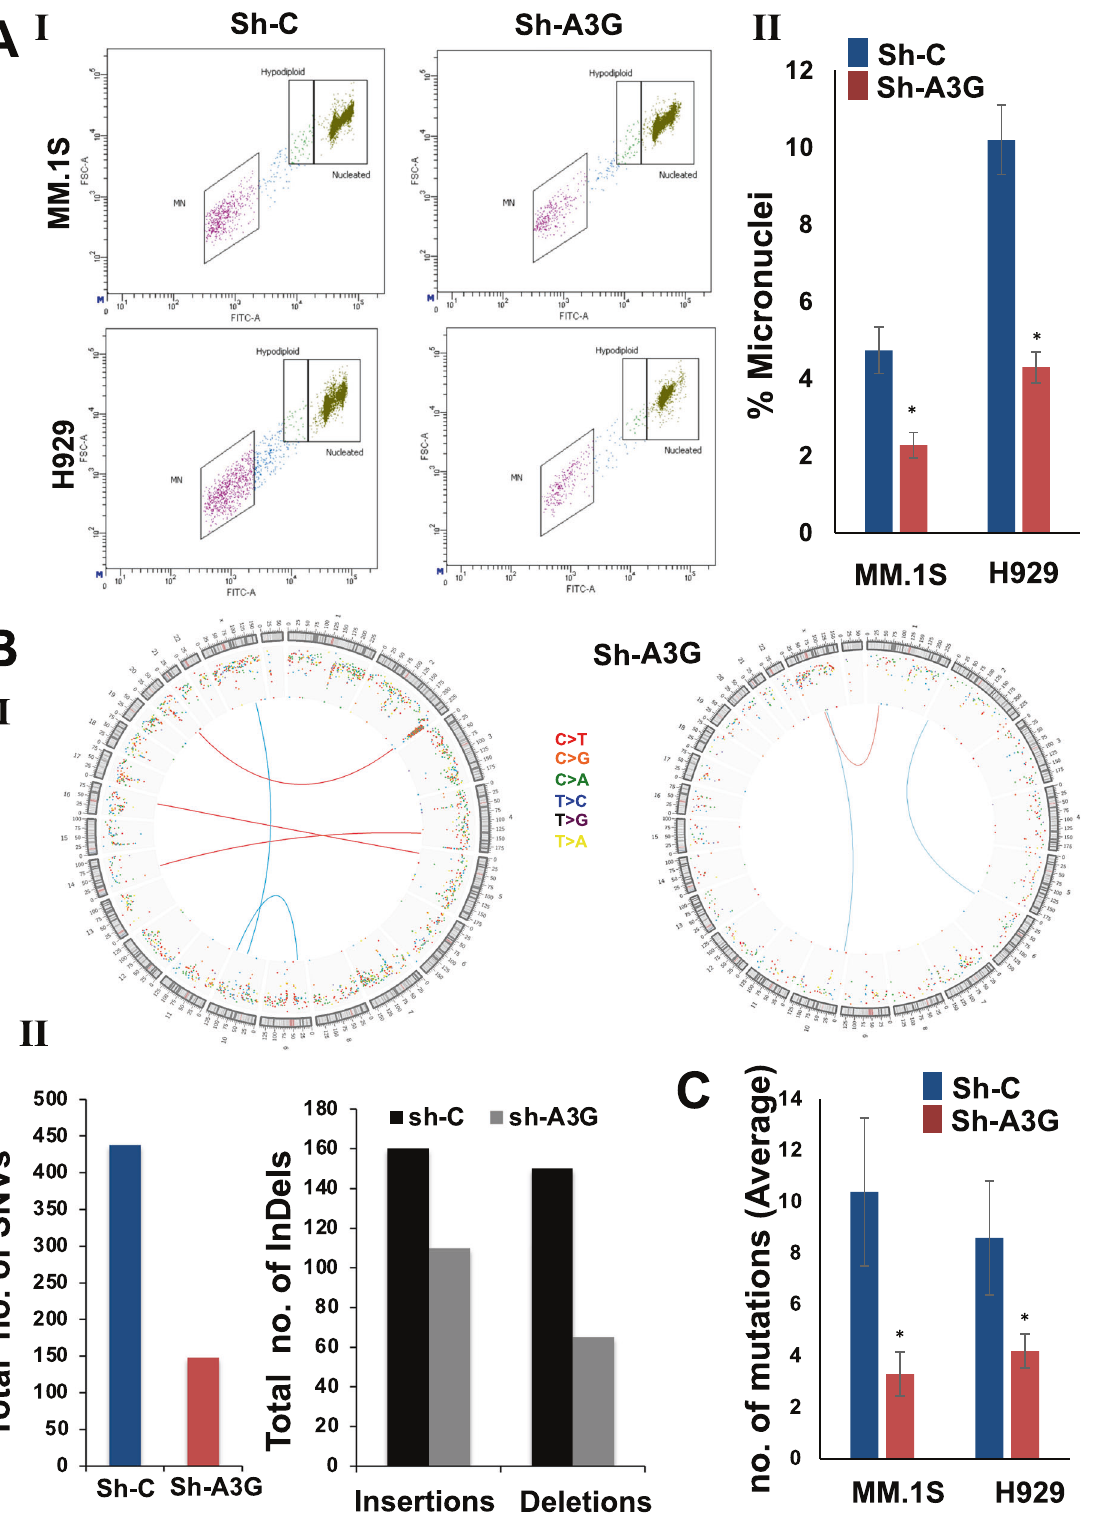
the fl uorescence which is detected by fl ow cytometry. As seen in Fig. 4E (panels I – II), A3G overexpression resulted in 1.7-fold increase ( p ≤ 0.05) in HR activity in U2OS cells. Consistently, the evaluation of HR activity in MM (U266) cell lysates showed a 2.5- fold increase ( p ≤ 0.05) in A3G-overexpressing, relative to control cells (Fig. 4E, panel